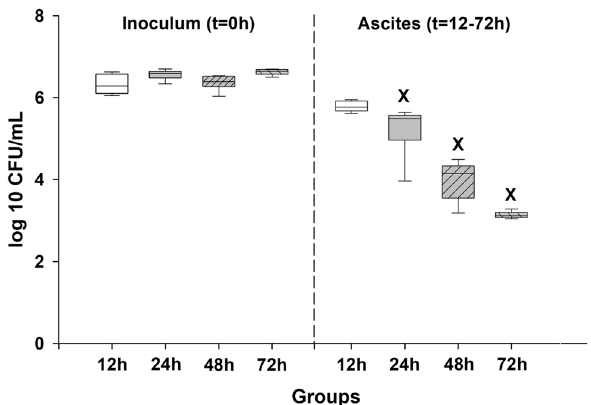
Figure 5. Bacterium concentration in the induction inocula and the abdominal fluids in the different sepsis groups representing different stages of sepsis. The number of animals used in the various sepsis groups is indicated in Table 1. Plots demonstrate the median (horizontal line in the box) and the 25th (lower whisker) and 75th (upper whisker) percentiles. Data were analyzed with two-way analysis of variance (ANOVA) followed by the Holm–Sidak post-hoc test. X P < 0.05 vs corresponding inducer inoculum.